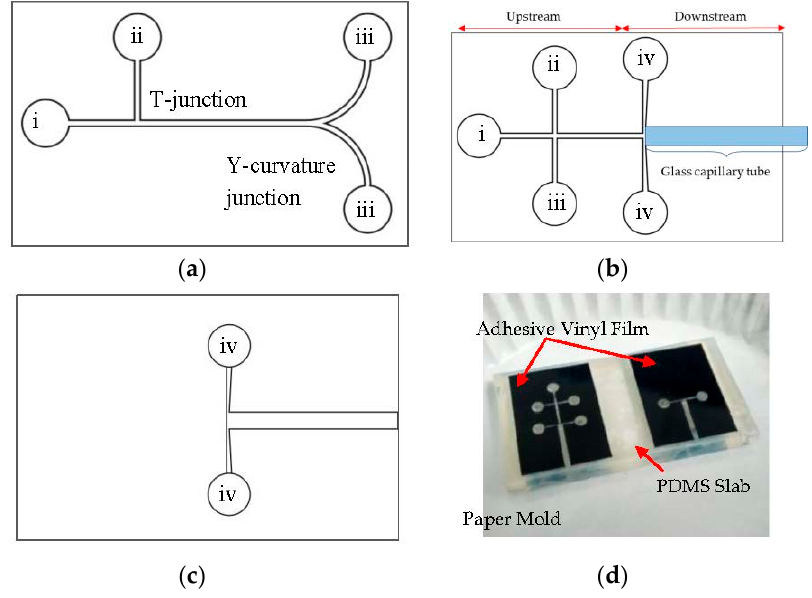
Figure 1. ( a ) Single layer microchannel design for droplet fission. The total length of the main channel is 28.10 mm with a 0.5 cm radii curve channel. (Label: i. cooking oil inlet; ii. DI water inlet; iii. Outlet). ( b ) Top layer design for droplet encapsulation. The channel height in the upstream is 0.2 mm. (Label: i. cooking oil inlet; ii. red dyed water inlet; iii. blue dyed water inlet; iv. yellow dyed water inlet). ( c ) Bottom layer design for droplet encapsulation to increase the downstream channel height to 1 mm for glass capillary tube fitting. (Label: iv. yellow dyed water inlet). ( d ) Layering for the fabrication of the epoxy master mold.